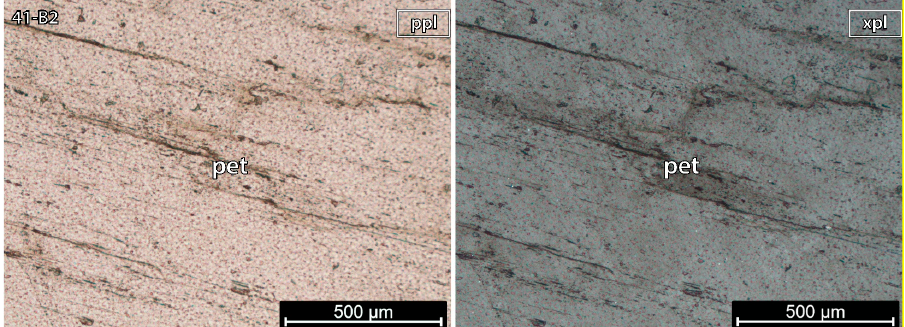
Figure 7. Microphotographs in parallel polarized light (ppl) and crossed polarized light (xpl) from a petalite (pet) fragment of the crystal sample 2 of the aplite-pegmatite 41 (41-B2). This is a pure petalite crystal without any traces of other minerals.